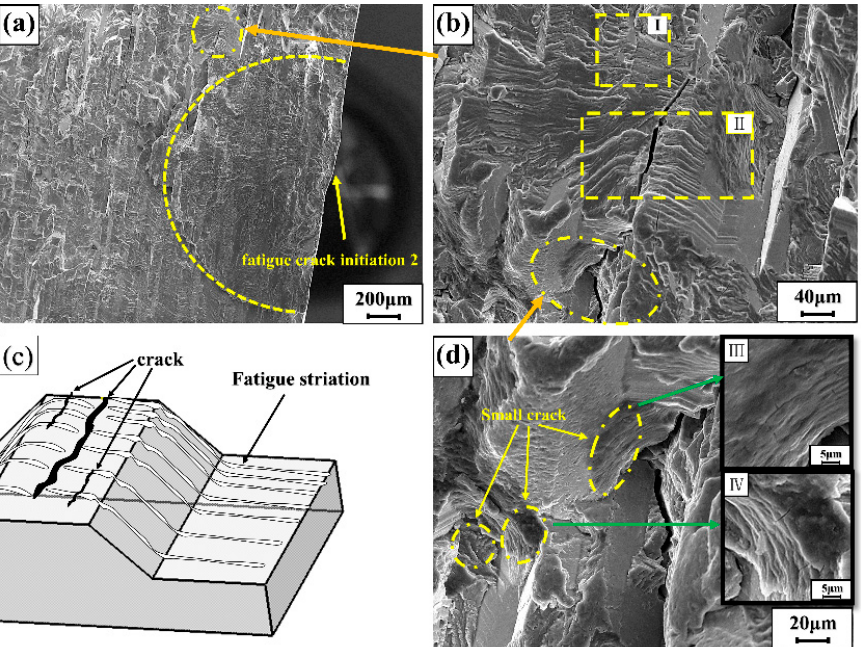
Figure 6. ( a ) Fatigue source zone 1; ( b ) partial enlarged view; ( c ) fatigue crack stable growth zone; ( d ) instantaneous fracture zone.